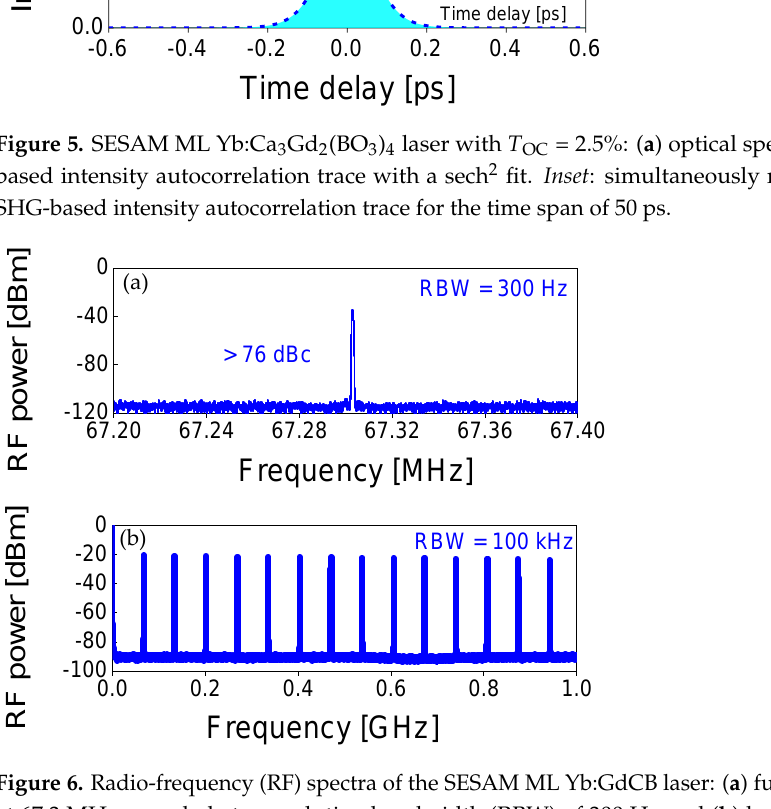
Figure 5. SESAM ML Yb:Ca 3 Gd 2 (BO 3 ) 4 laser with T OC = 2.5%: ( a ) optical spectrum and ( b ) SHG-based intensity autocorrelation trace with a sech 2 fit. Inset : simultaneously measured long-scale SHG-based intensity autocorrelation trace for the time span of 50 ps.